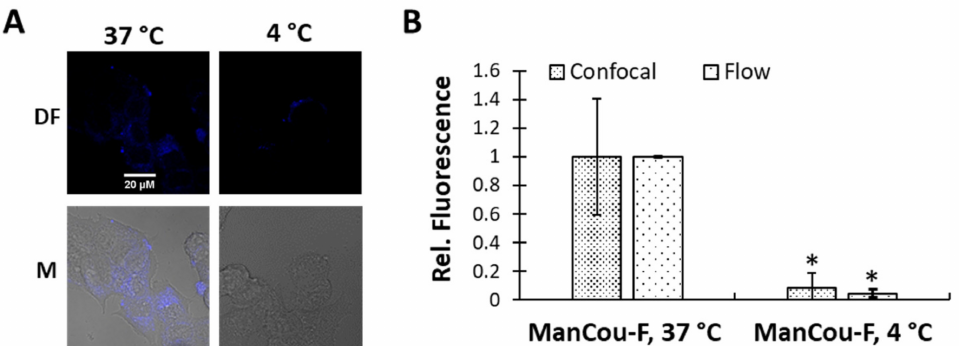
Figure 4. ManCou-F (25 µ M) uptake in MCF7 cells preconditioned and treated at 37 ◦ C vs. 4 ◦ C for 15 min. Fluorescence was analyzed by confocal microscopy and flow cytometry. ( A ) Representative images were acquired using 60 × objective and DAPI filter (exc/em: 405 nm/461 nm) at the same laser intensity and exposure time, DF—dark field, and M—fluorescence overlay images with the bright field. ( B ) Quantification of fluorescence derived from corresponding fluorescence images using ImageJ as CTCF/Area. A total of two images were analyzed per sample per experiment (~5–10 cells/image). Fluorescence obtained by Attune NxT Flow Cytometer using VL1 filter was processed as MFI probe (median of fluorescence intensity)-MFI negative (MFI of the cells with no treatment). MFI was derived excluding debris and doublets by FSC-SSC and FSC-H-FSC-W gating, respectively. Each experiment was carried out in duplicate. Error bars represent the relative standard deviation derived by dividing the individual standard deviation by the average. A two-tailed t -test was used to detect statistically significant differences: * p < 0.05. Levels of probe uptake were corrected by the corresponding value obtained for 37 ◦ C to represent relative fluorescence. The scale bar for all images is 20 µ